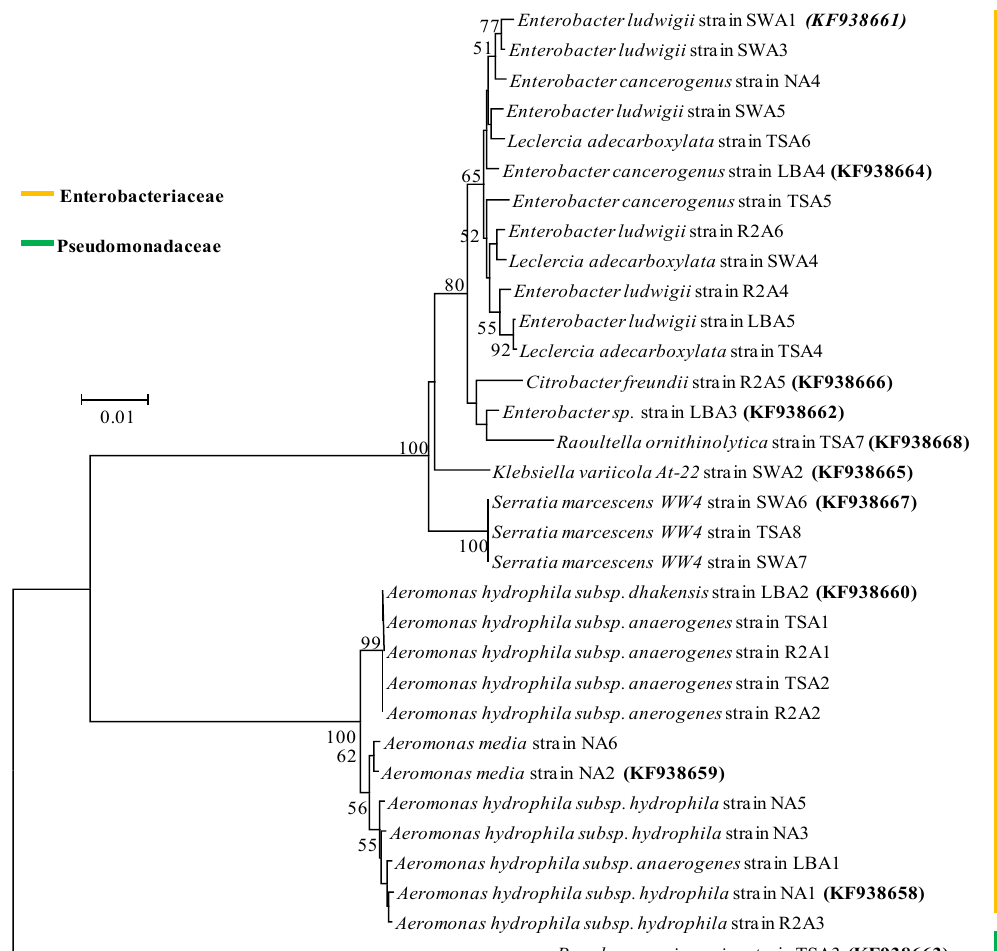
Figure 4. Phylogenetic relationship of the AHLs producing bacteria isolated from membrane bioreactor activated sludge. The tree was constructed using neighbor joining algorithm with Kimura 2 parameter distances in MEGA 4.0 software. Numbers at the nodes indicate percent bootstrap values above 50 supported by 550 replicates. The bar indicates the Juke-Cantor evolutionary